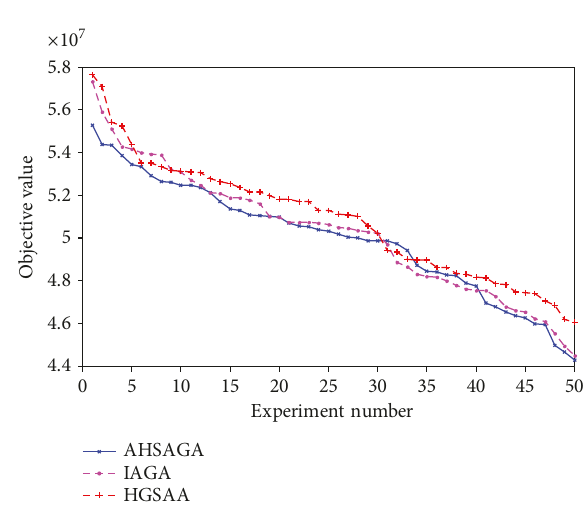
Figure 6: Objective values from AHSAGA, HGSAA, and IAGA (Gaskell67-21 ×